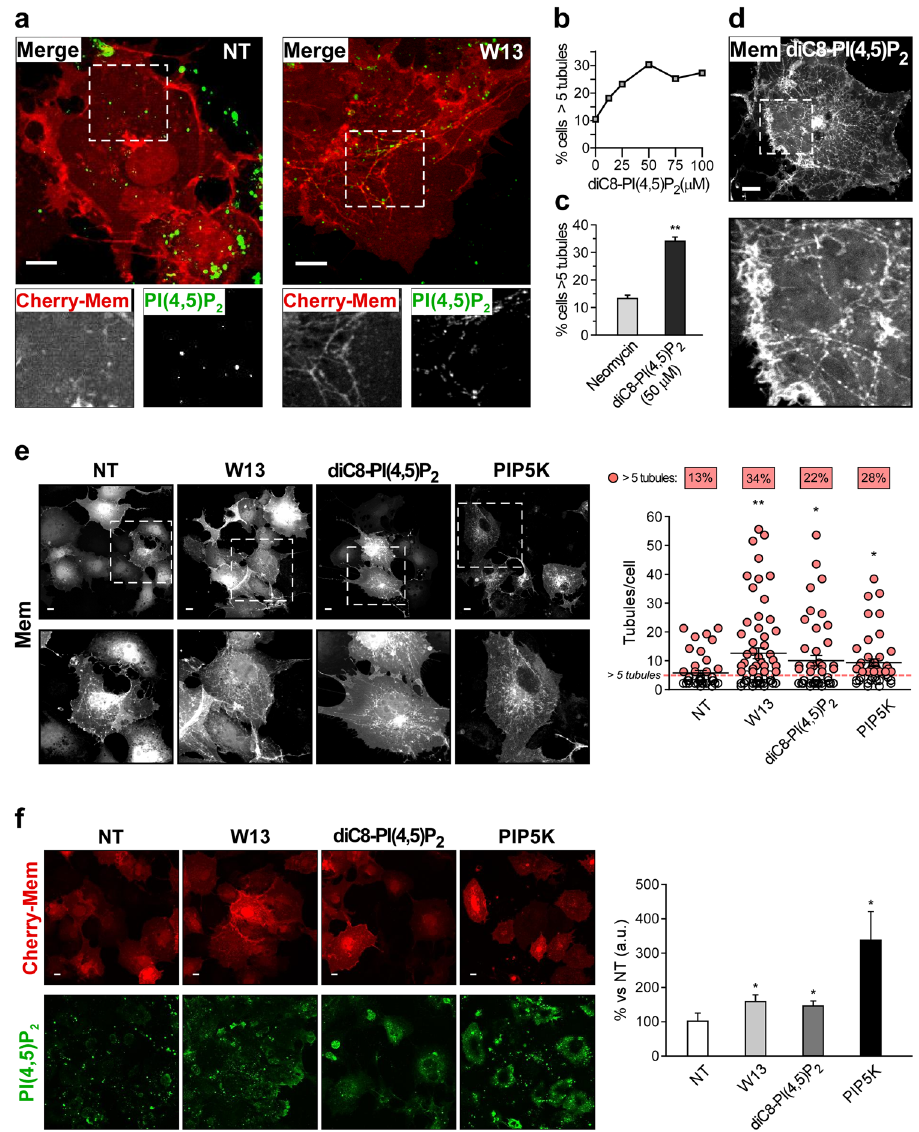
Figure 2. Increased levels of PI(4,5)P 2 induces membrane tubules at the PM. ( a ) COS1 cells expressing Cherry- Mem grown on coverslips were incubated with W13 (20 min, 4.5 µ g/ml). After fixation (PFA 4%, 15 min at 37 °C), endogenous PI(4,5)P 2 was detected with a specific antibody and the corresponding anti-mouse Alexa- 488 labeled secondary antibody. The images were acquired with a confocal microscope (Leica TCS SP5) and magnification insets show the presence of PI(4,5)P 2 in W13-induced membrane tubules. ( b ) The percentage of cells presenting more than 5 tubules was determined after 20 min of diC8-PI(4,5)P 2 dose-response at the indicated concentrations. ( c ) The percentage of cells with tubules after 20 min incubation with 50 µ M diC8-PI(4,5)P 2 or neomycin control. ( d ) Confocal image of cherry-mem depicted tubules in cells treated with diC8-PI(4,5)P 2 as in ( c ) (bars, 10 µ m). ( e) In Cherry-Mem expressing cells, the percentage of cells presenting tubules and the number of tubules per cell were determined in different experimental conditions: W13 (20 min, 4.5 µ g/ml), diC8-PI(4,5)P 2 (20 min, 50 µ M) or GFP-PIP5K expression. Statistical significance between the different conditions and the control (NT, non-treatment) was determined by the unpaired Student’s t -test, ** p < 0.01 (n = 100 cells per condition). Representative confocal images acquired through the red channel and insets displaying cells presenting cherry-Mem decorated tubules are shown (bars, 5 µ m). ( f ) In the same experimental conditions as in ( e ), the intracellular levels of PI(4,5)P 2 were determined by immunofluorescence performed as in ( a ). Graph shows the percentage of fluorescence (a.u., arbitrary units) of each condition vs NT, mean values ± standard error of the mean (SEM) from three independent experiments. Statistical significance between the different conditions and the NT was determined by the paired Student’s t -test, * p < 0.05. Representative z-stacks confocal projection images are shown (bars, 10 µ